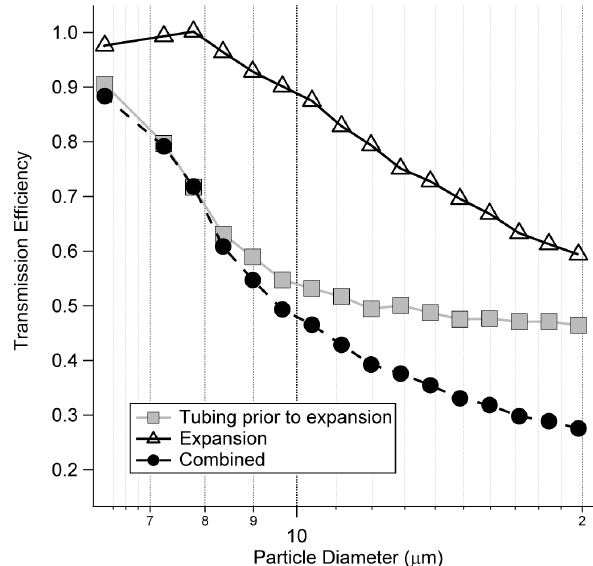
Fig. 4. Transmission efficiency for hollow glass beads through vari- ous parts of the CVI inlet based on wind tunnel experiments with the inlet not operating in counter-flow mode. The decrease in transmis- sion efficiency is a result of various types of particle losses through each section. “Tubing prior to expansion” refers to Segment B in Fig. 1 and “Expansion” refers to Segment C in Fig.